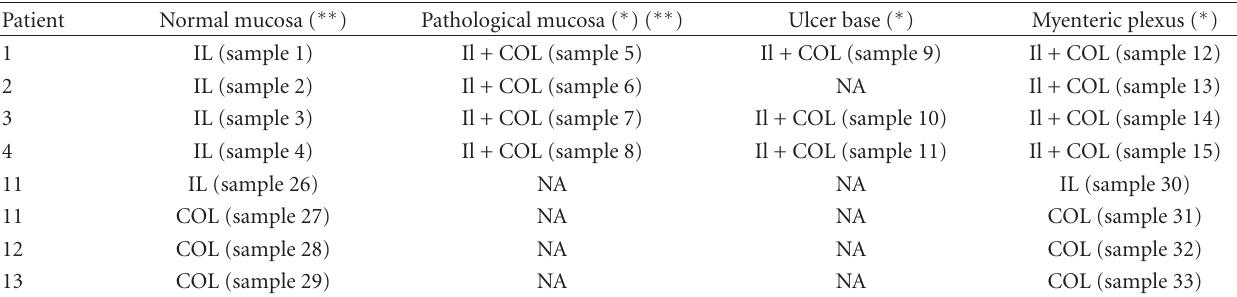
Table 2: Histological structures and lesions selected for LCM.